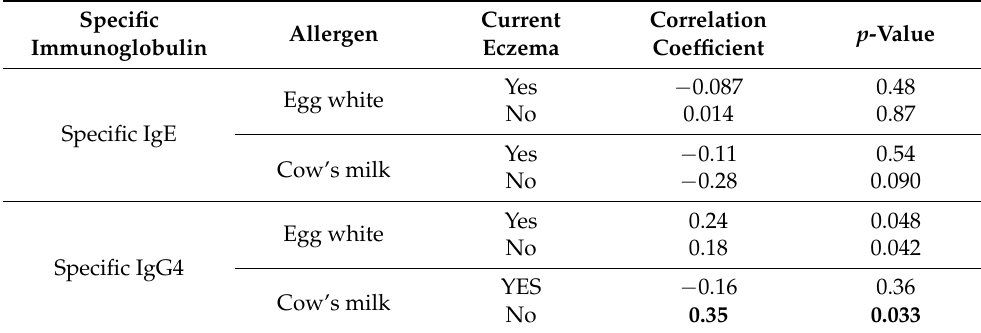
Table 2. Correlation between endotoxin concentration and EW- and CM-specific IgE and IgG4 levels in subgroups of children with and without eczema.